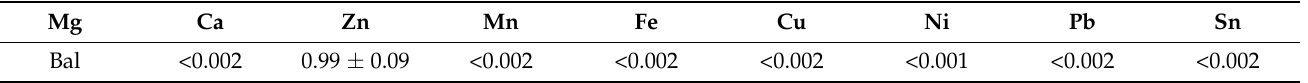
Table 1. Chemical composition (wt. %) of the as-cast binary Mg-Zn alloy.